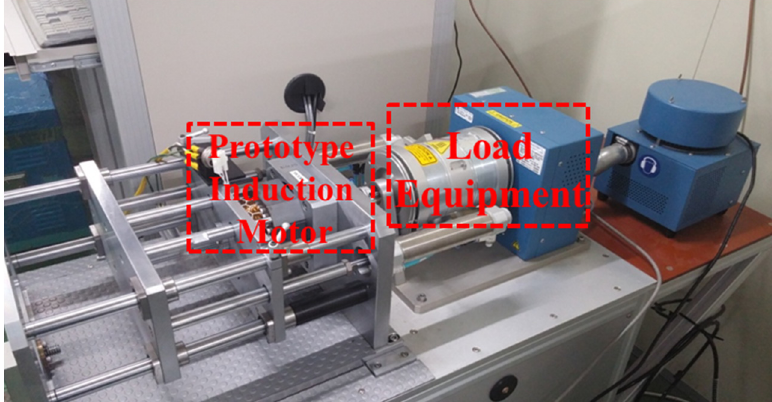
Figure 11. Experimental dynamometer setup for the test of prototype.